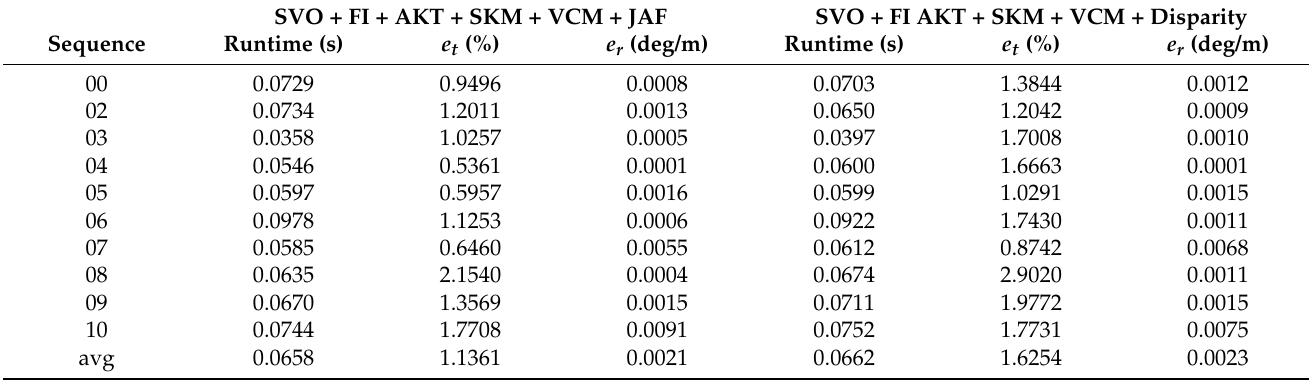
Table 1. Comparison of the proposed method to a version that determines the AKT window size using only disparity information on the KITTI dataset. (deg/m stands for degrees per meter). SVO + FI + AKT + SKM + VCM + JAF SVO + FI AKT + SKM + VCM +